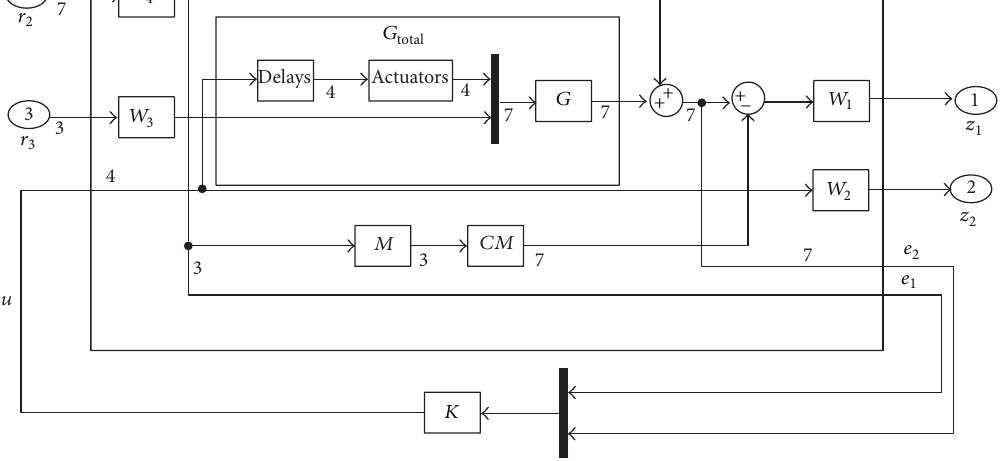
Figure 4: Inner loop architecture.